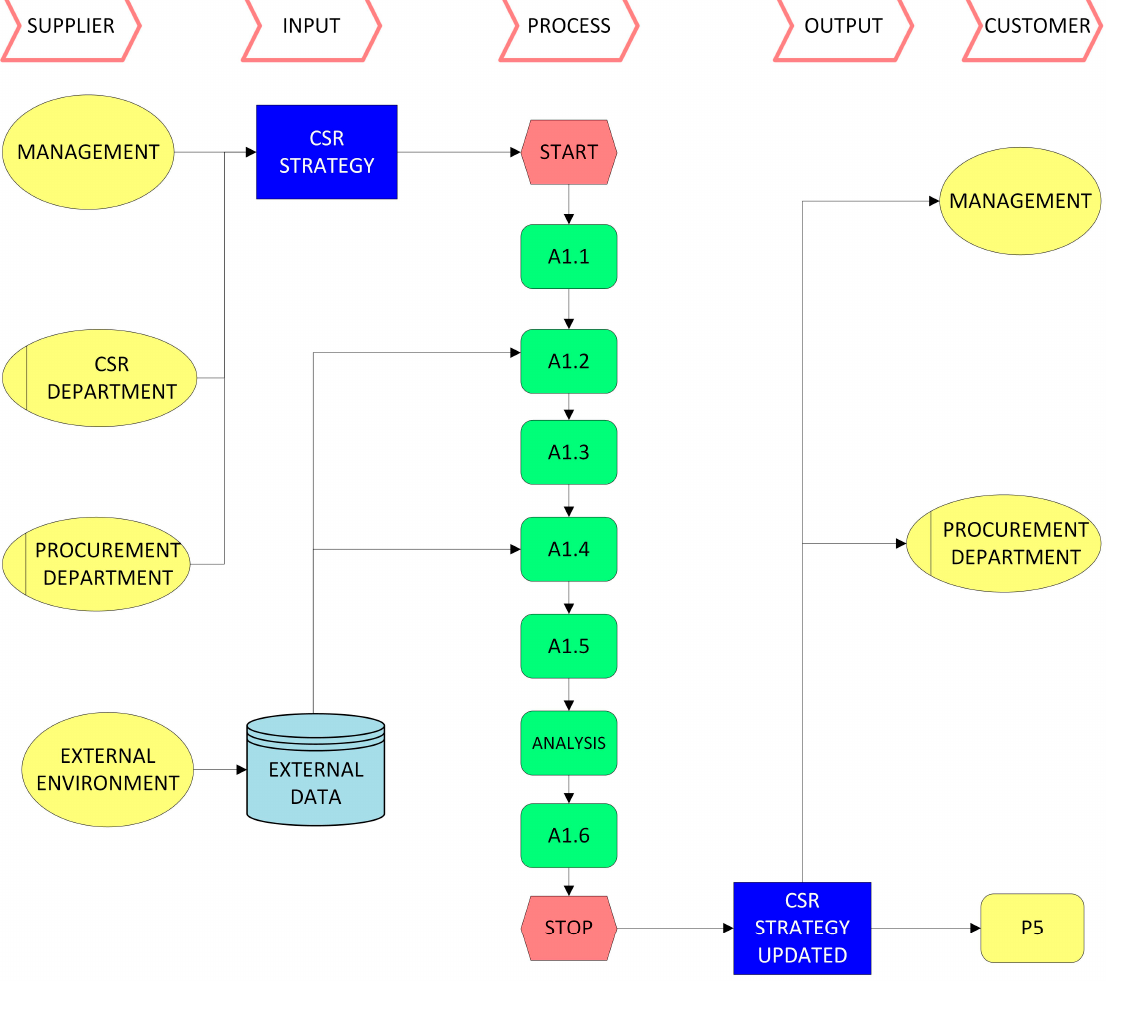
Figure 1. Future state for P1